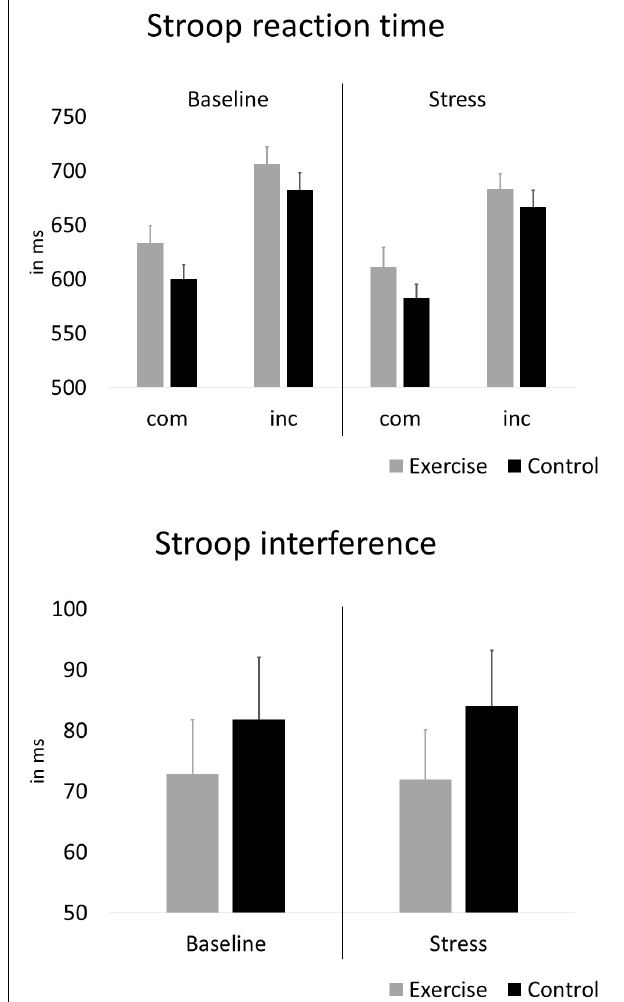
FIGURE 4 | Average Stroop reaction time during compatible (com) and incompatible (inc) test blocks and interference scores before and under stress. Error bars are standard errors of the mean